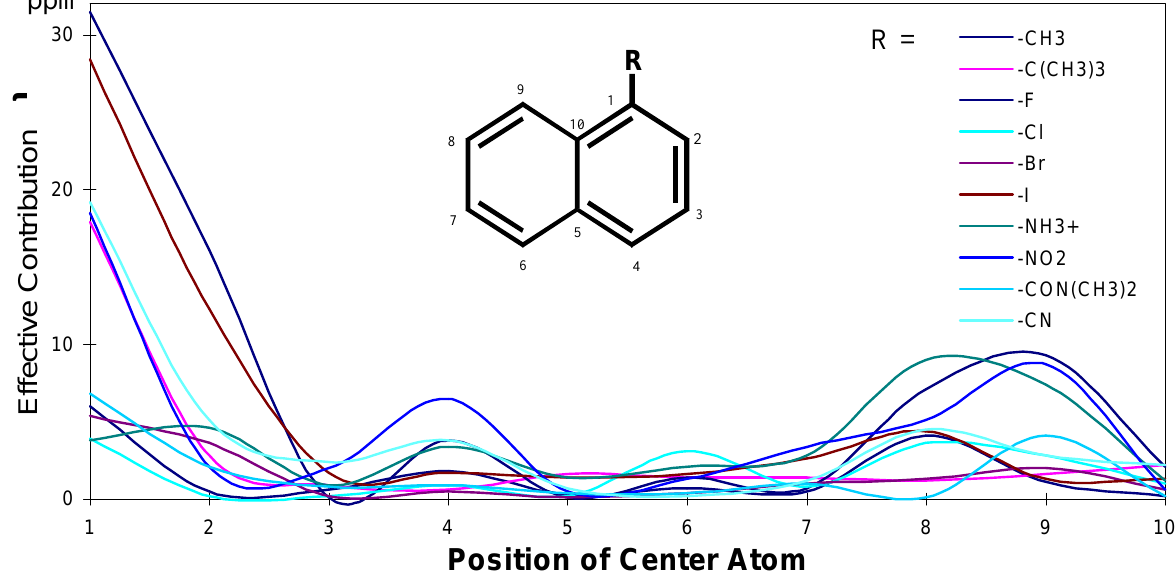
Figure 3. Chemical environment and its effect on central carbon atoms in aromatic